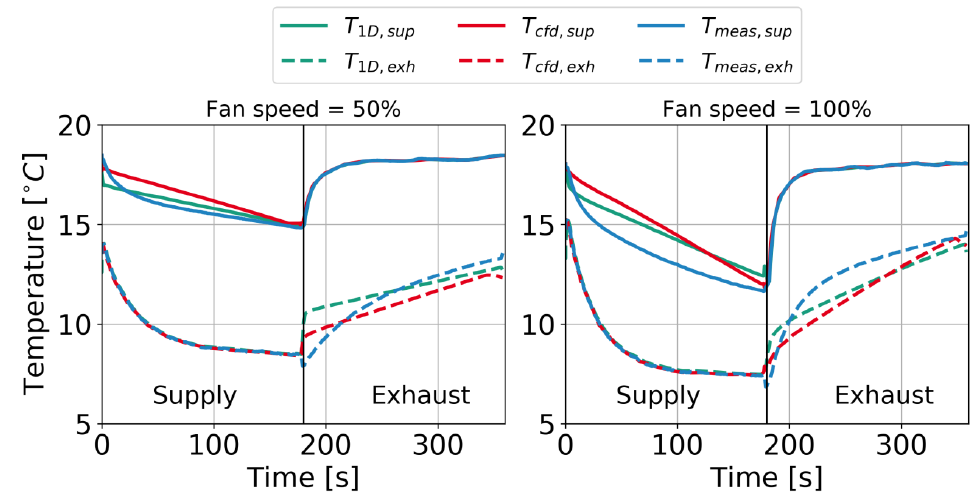
Figure 17. Supply and exhaust temperature comparison between both simulation models and measurements with 180 s phase. Table 8. Performance indicators regarding the supply temperature for both simulation